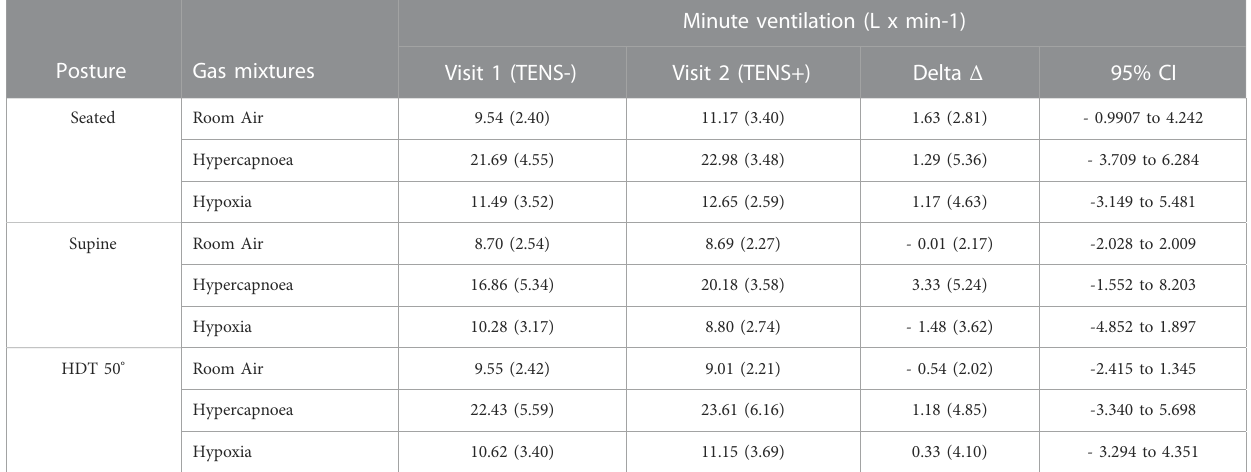
TABLE 8 Minute ventilation with and without electrical stimulation in seated, supine and HDT postures. Data are presented as mean (SD), HDT: head down tilt. TENS-, electrical current off. TENS + electrical current turned on. CI, 95% con fi dence interval.